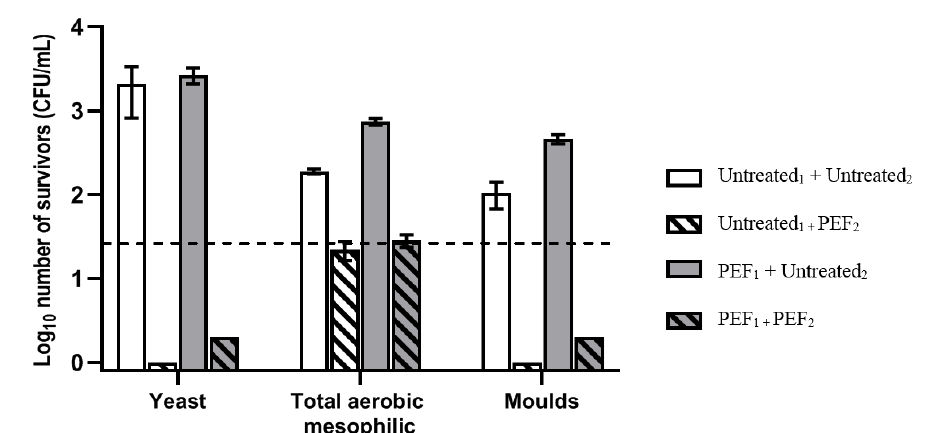
Figure 2. Impact of PEF treatment (17.5 kV/cm) on the number of survivors of yeast, total aerobic mesophilic bacteria and moulds in the grape juices. White bars (juice from untreated grapes without decontamination by PEF), white and dashed bars (juice from untreated grapes decontaminated by PEF), grey bars (juice from PEF-treated grapes without decontamination by PEF) and grey and dashed bars (juice from PEF treated-grapes decontaminated by PEF). Dashed line represents the quantification limit (30 CFU/mL ≈ 1.5 log 10 CFU/mL).